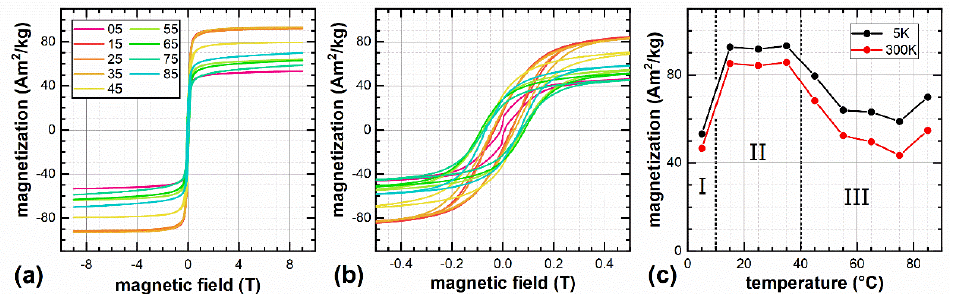
Figure 4. Magnetization of sample S05 to S85 recorded at 5 K in external magnetic fields up to 9 T ( a ) shown in magnification in ( b ). Maximum magnetization values recorded at 9 T at 5 K and 300 K, respectively ( c ), showing three distinct regions (I–III) with different magnetic behavior dependent on particle preparation temperature, as outlined in the text.